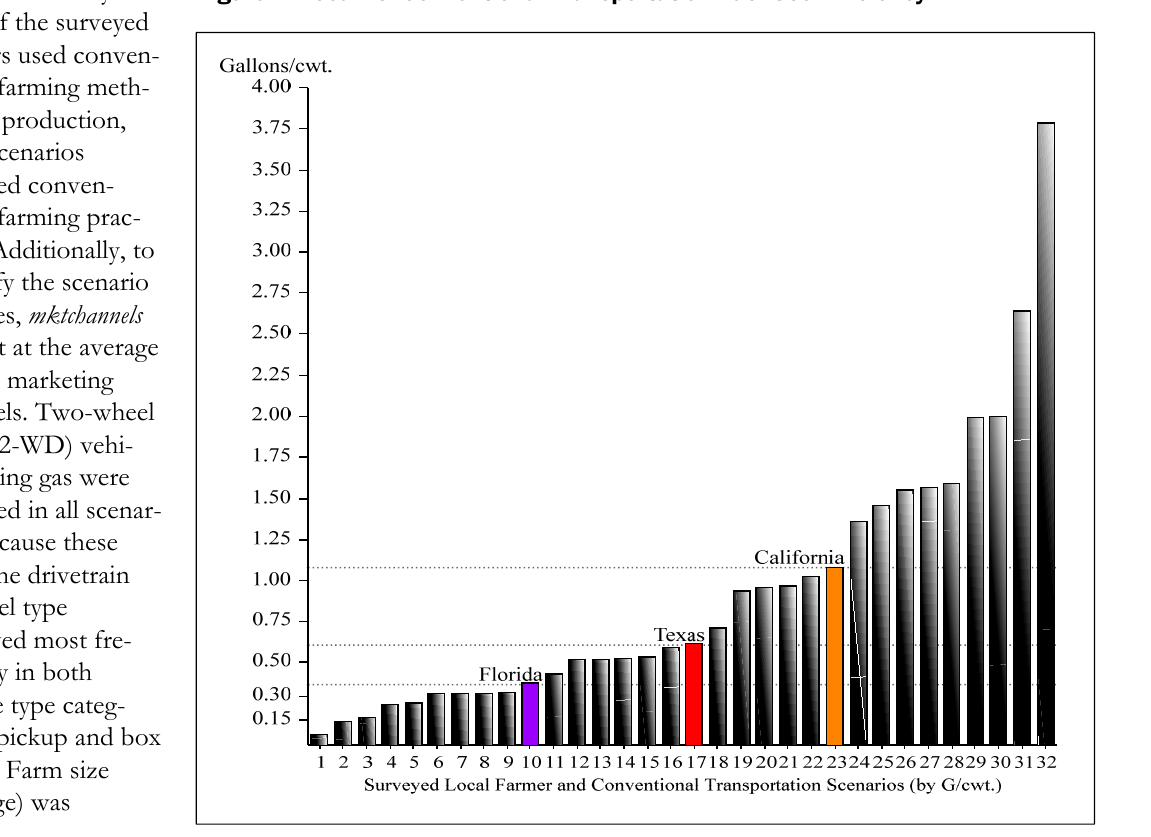
Figure 2. Local vs. Conventional Transportation Fuel-Use